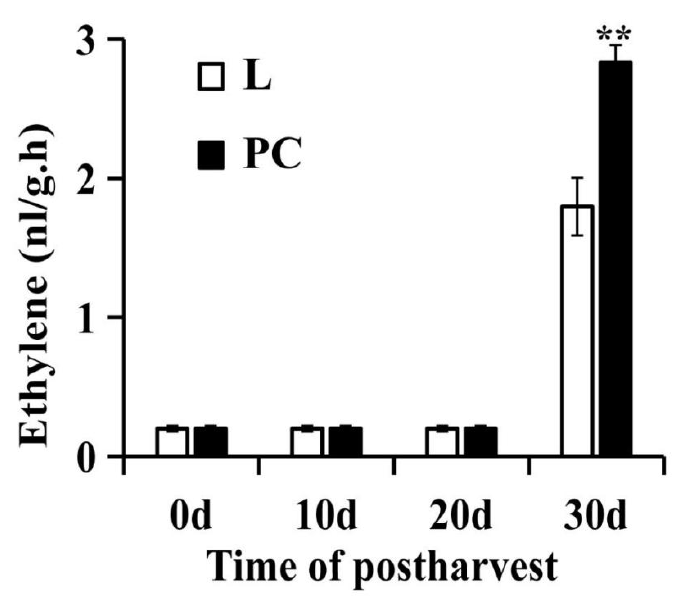
Figure 8. PC promoted ethylene production in SH peach fruit under low temperatures. Error bars represent the standard error (SE) calculated from three independent biological replicates. Asterisks (**) indicate significant differences ( p < 0.01; Student’s t -test).